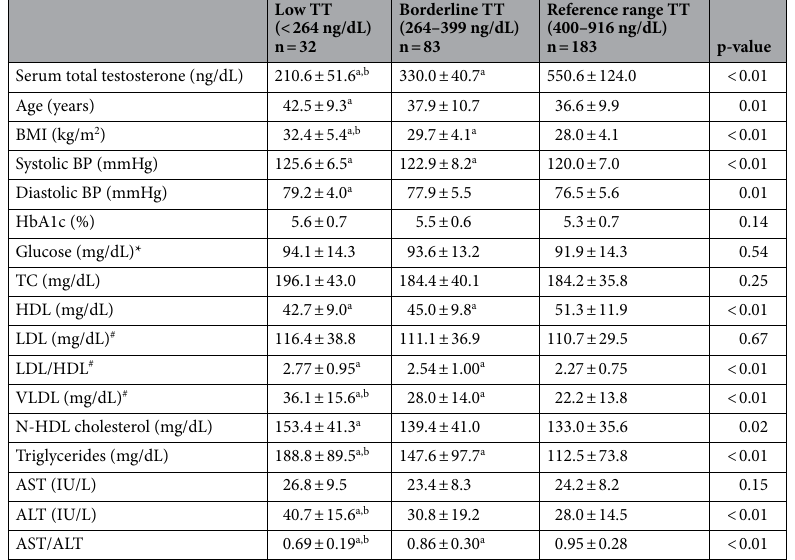
Table 2. Comparison of cardiometabolic parameters among firefighters within different categories of serum total testosterone levels. a Significantly different when compared to reference group (Tukey’s post-hoc); b Significantly different when compared to borderline group; Different sample sizes for the variables: *Low TT (n = 31), Borderline TT(n = 81), and Reference TT (n = 181); # Low TT(n = 31), Borderline TT(n = 81), and Reference TT (n = 182). BMI (Body Mass Index); BP: Blood Pressure; HbA1c: Glycated Hemoglobin; TC: Total cholesterol; HDL: High Density Lipoprotein-cholesterol; LDL: Low Density Lipoprotein-cholesterol; VLDL: Very Low Density Lipoprotein- cholesterol; AST: Aspartate Aminotransferase; ALT: Alanine